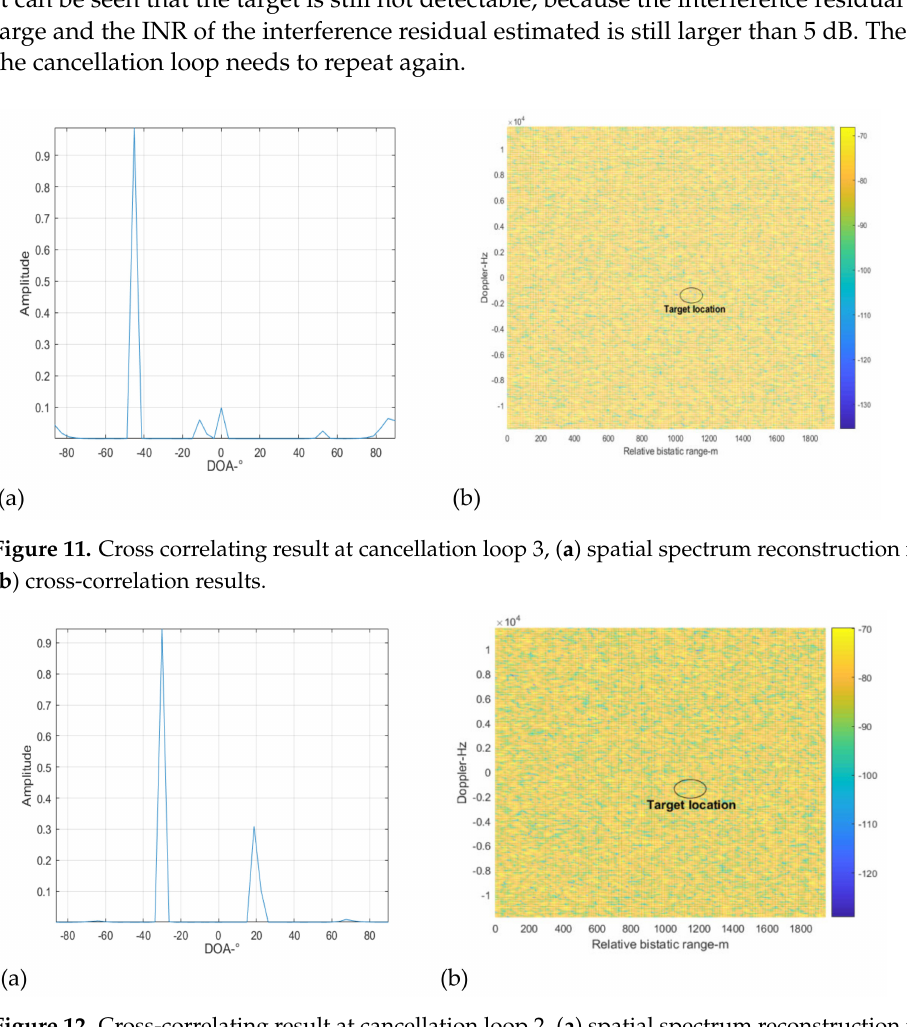
Figure 12. Cross-correlating result at cancellation loop 2, ( a ) spatial spectrum reconstruction results, ( b ) cross-correlation